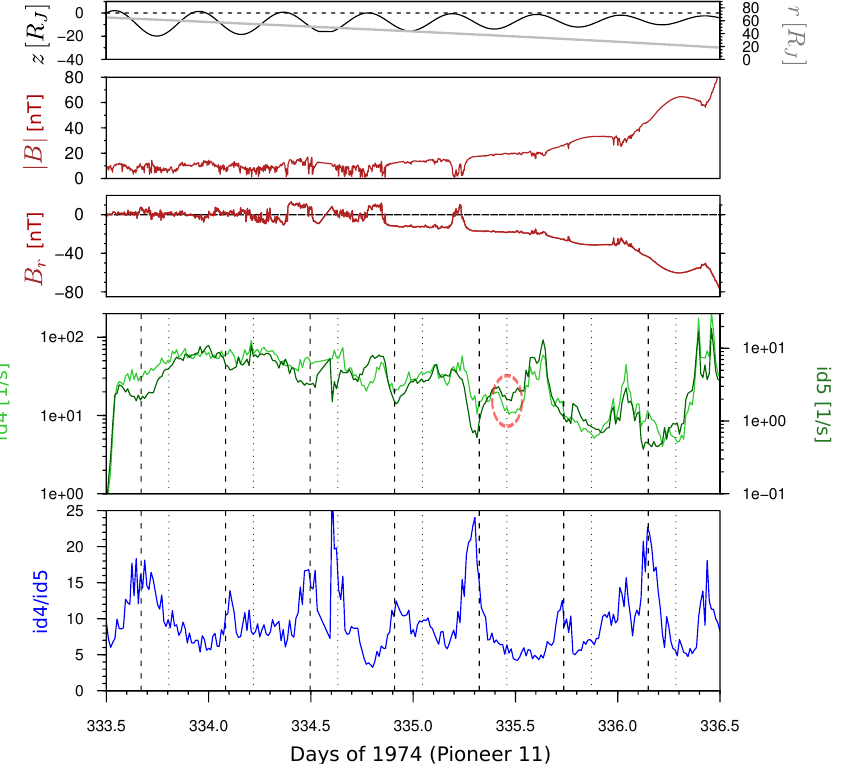
Fig. 10. Pioneer 11 data for the spacecraft’s inbound pass from day 333.5 to 336.5 in 1974, showing the same quantities as Fig. 7. Compared